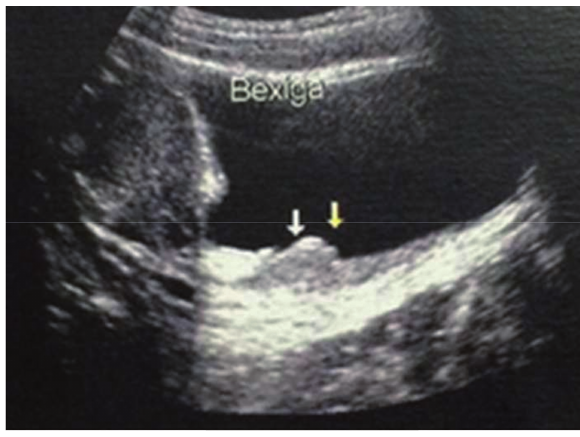
figure 1 - focal thickening of 3.0 x 3.0cm in the bladder wall at the level of the right uretero-vesical junction.